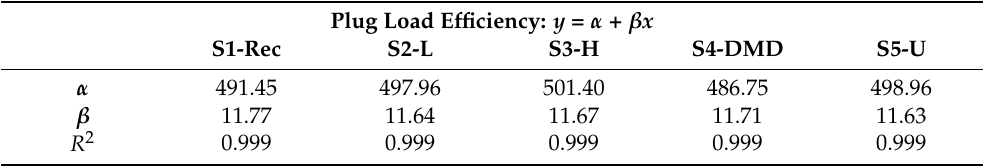
Table 8. Summary of plug load efficiency regression equations.